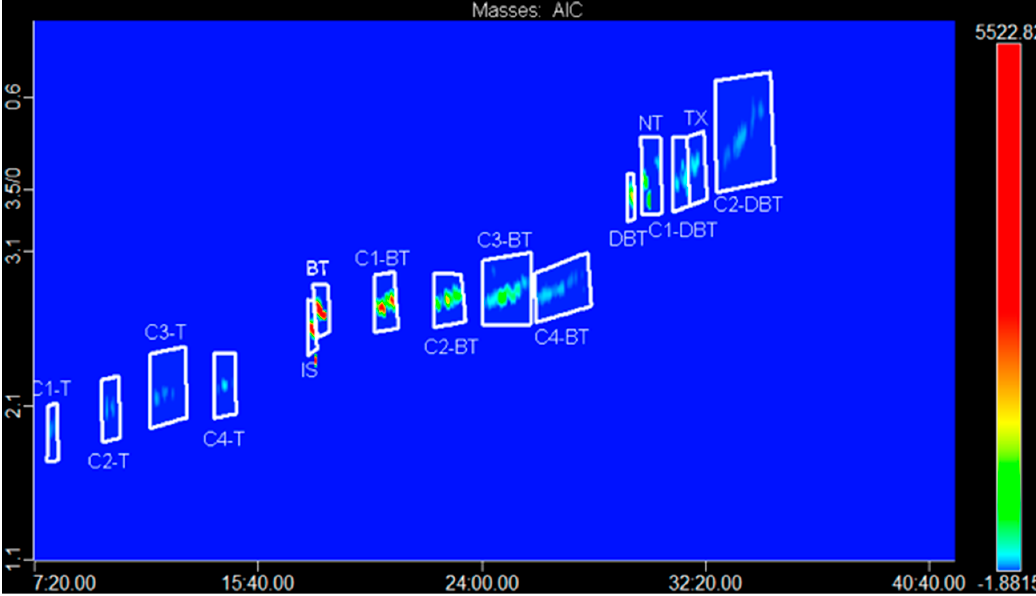
Figure 3. Extracted ion chromatogram expansion highlighting a coelution between C1-BT (spectrally identified as 2-methyl[b]benzothiophene) and C1-N (spectrally identified as 1-methylnaphthalene) ( a ). Deconvoluted mass spectrum for 1-methylnaphthalene ( b ) and 2-methyl[b]benzothiophene ( c ). 3.3. Quantitative Analysis In order to perform quantitative analysis, eight-point calibration curves across two orders of magnitude were constructed for the eight SAHs. The ppb concentration range for each compound is shown in Table 3, along with the quantifier ion (the base peak). In all cases, the lowest calibration point was approx. at the 5 ppb level, while the upper one was approx. at the 500 ppb level. The internal standard (1-fluoronaphthalene) was added to all solutions at a concentration of 89 μ g L − 1 . Eight replicates were carried out at the three lowest points, while six consecutive analyses were performed for the other concentrations. Coefficients of determination were in the range 0.97414– 0.98941. The quantifier ions, along with the average mass error values (range: 1.0–3.4 ppm), for the eight SAHs as well as for the IS, are also reported. Limits of detection (LoD) and quantification (LoQ) values were calculated by dividing the standard deviation of the response at the lowest calibration point by the equation slope, and then by multiplying the result by 3 and 10, respectively. Finally, the LoDs and LoQs were adjusted by considering the initial sample dilution (100 mg L − 1 ), and were in